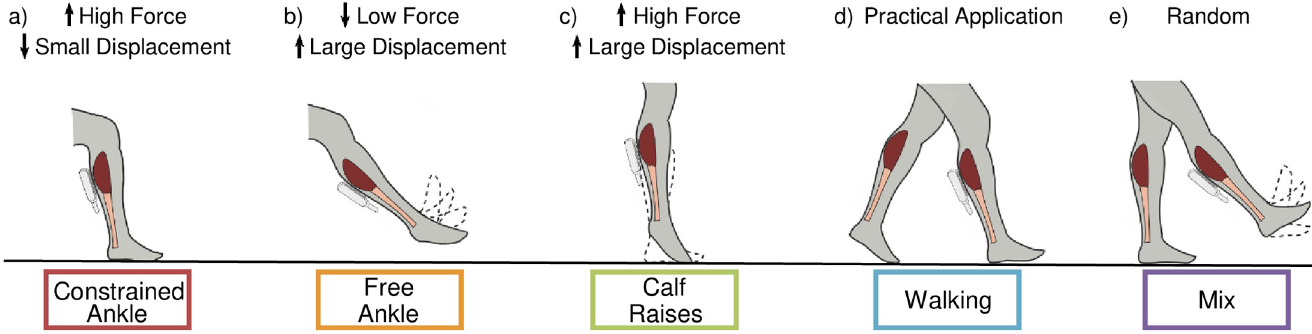
Fig 1. Ankle movement tasks used to generate experimental data set of B-mode ultrasound images. Dynamic B-mode ultrasound data were collected from the human soleus muscle for five ankle movement tasks with varying levels of force and displacement. Tasks were as follows: (a) (red) seated, constrained ankle plantarflexion with cyclic pushes of the foot on the ground and legs held still, (b) (orange) seated, free ankle plantar/dorsiflexion with foot in the air, c) (green) weight- bearing, calf raises with cyclic heel raises while standing in place, d) (blue) walking at 1.5 m/s on a treadmill, and e) (purple) a mix of directed movements while standing in place with foot on the ground and in the air. Tasks were specifically chosen to elicit combinations of high/low muscle fascicle force and displacement to provide a data set for training machine learning (ML) algorithms that had a high degree of variability. Task color coding is consistent throughout the paper.